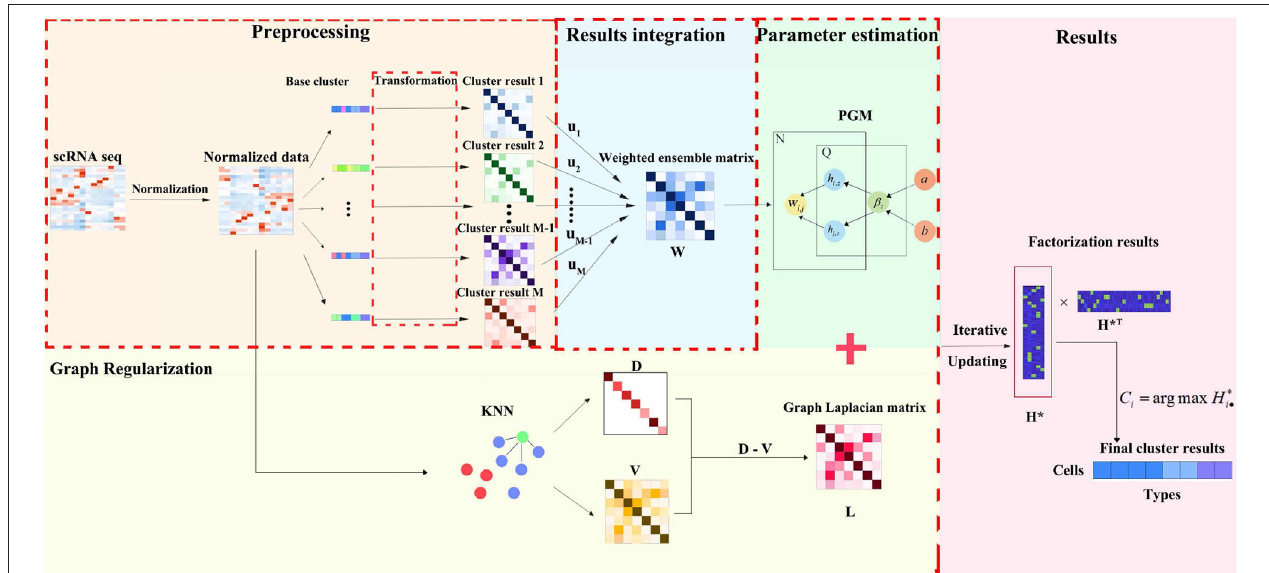
FIGURE 1 | The flowchart of EC-PGMGR. It comprises of preprocessing, results integration, graph regularization and parameter estimation four steps. Normalized scRNA-seq data is first input into individual clustering methods to generate cluster results, then single results are integrated into a weight combination form, which serves as initial input to EC-PGMGR. Finally, the final clustering result can be obtained by the estimated parameters in EC-PGMGR.